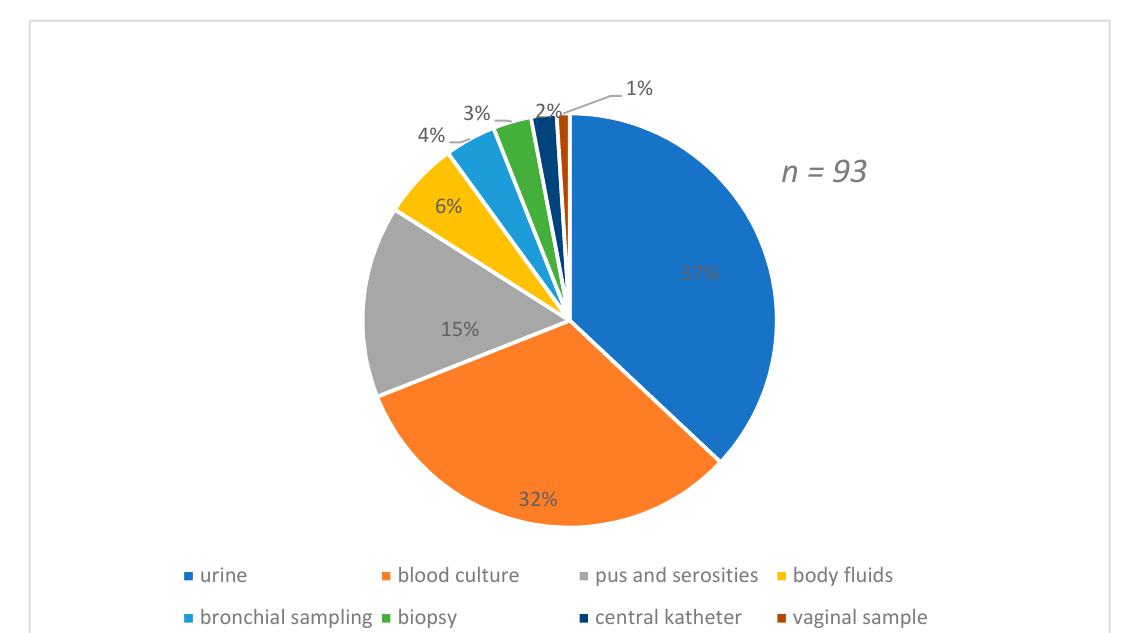
Figure 1. Distribution of the strains isolated according to the nature of the sample.